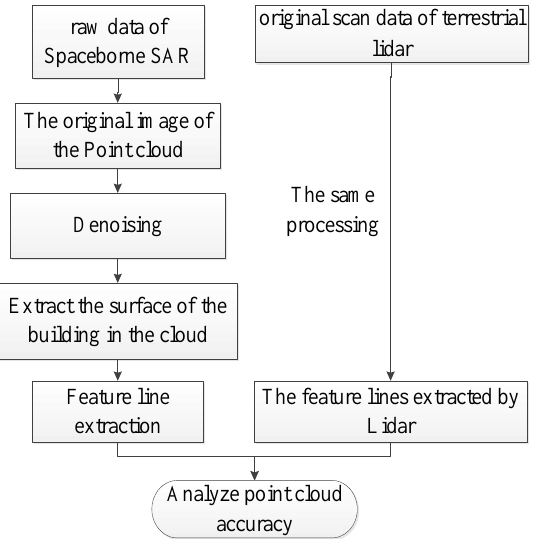
Fig3-1 Flow Chart of Accuracy